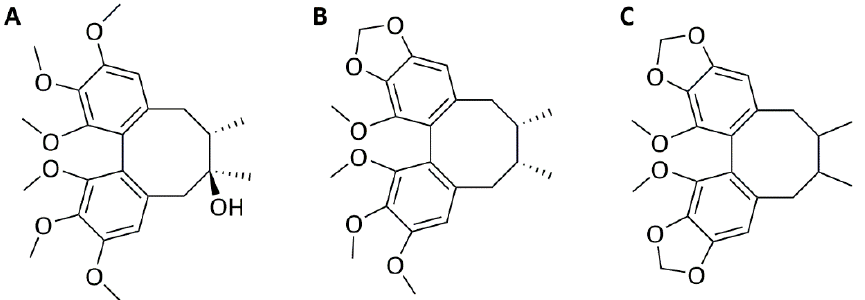
Figure 1. Chemical structures of dibenzocyclooctadiene lignans ( A ) schisandrin, ( B ) schisandrin B, and ( C ) schisandrin C.